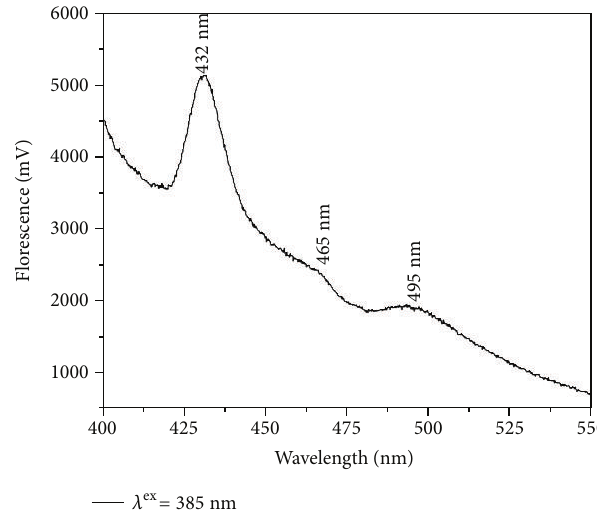
Figure 5: Room temperature PL spectrum of annealed MgO nanoparticles under the excitation wavelength of 385 nm.